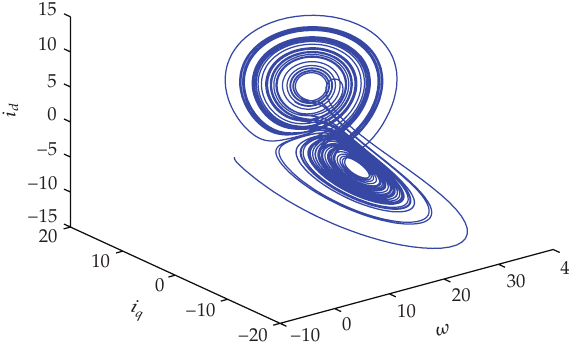
Figure 1: Typical chaotic attractor in PMSM with system parameters σ (cid:8) 5.45 and γ (cid:8)